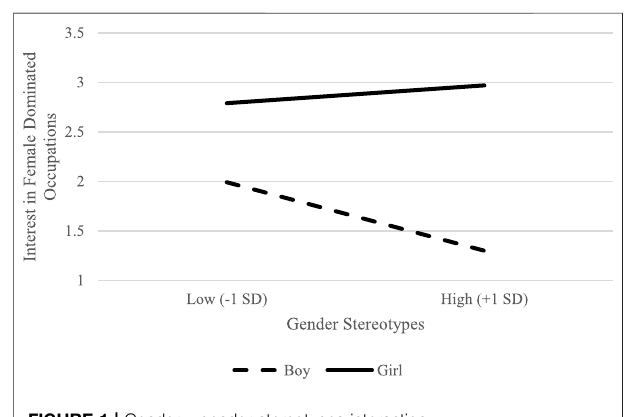
FIGURE 1 | Gender x gender stereotypes